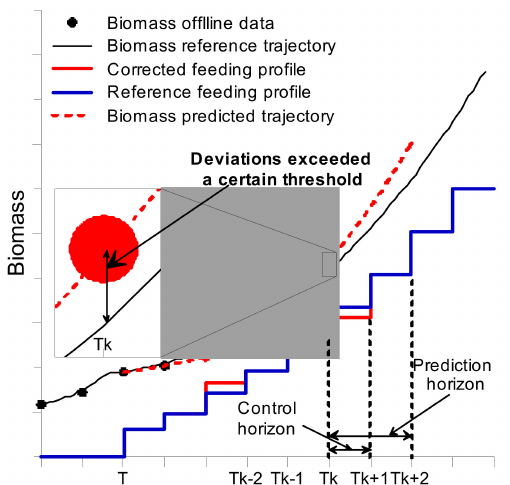
Figure 2. Model predictive control (MPC) operation principle. Tk—actual point k in time, Tk − 1—Past (measured values), Tk+1—Future (predicted